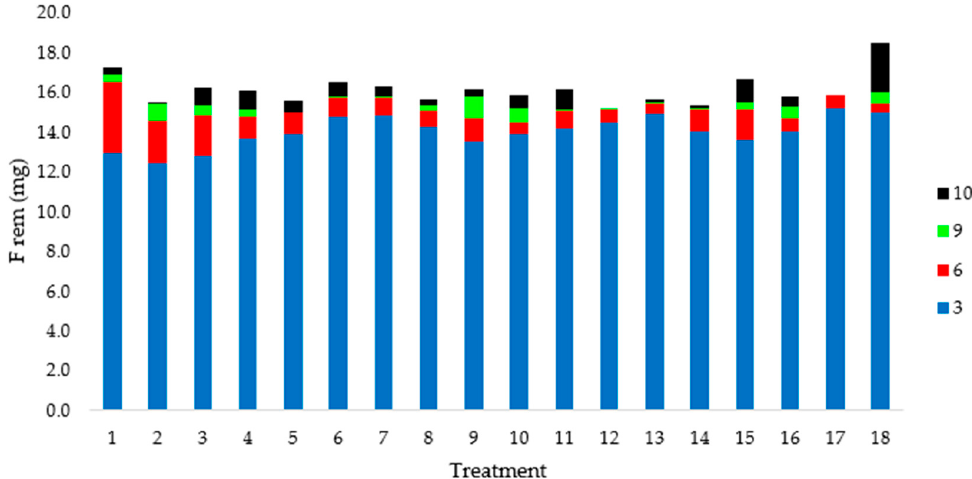
Figure 6. Increments of fluoride removals (mg) until day 3 (blue), 6 (red), 9 (green), and 10 (black) for treatments 1–18 on the CCRD experiment.